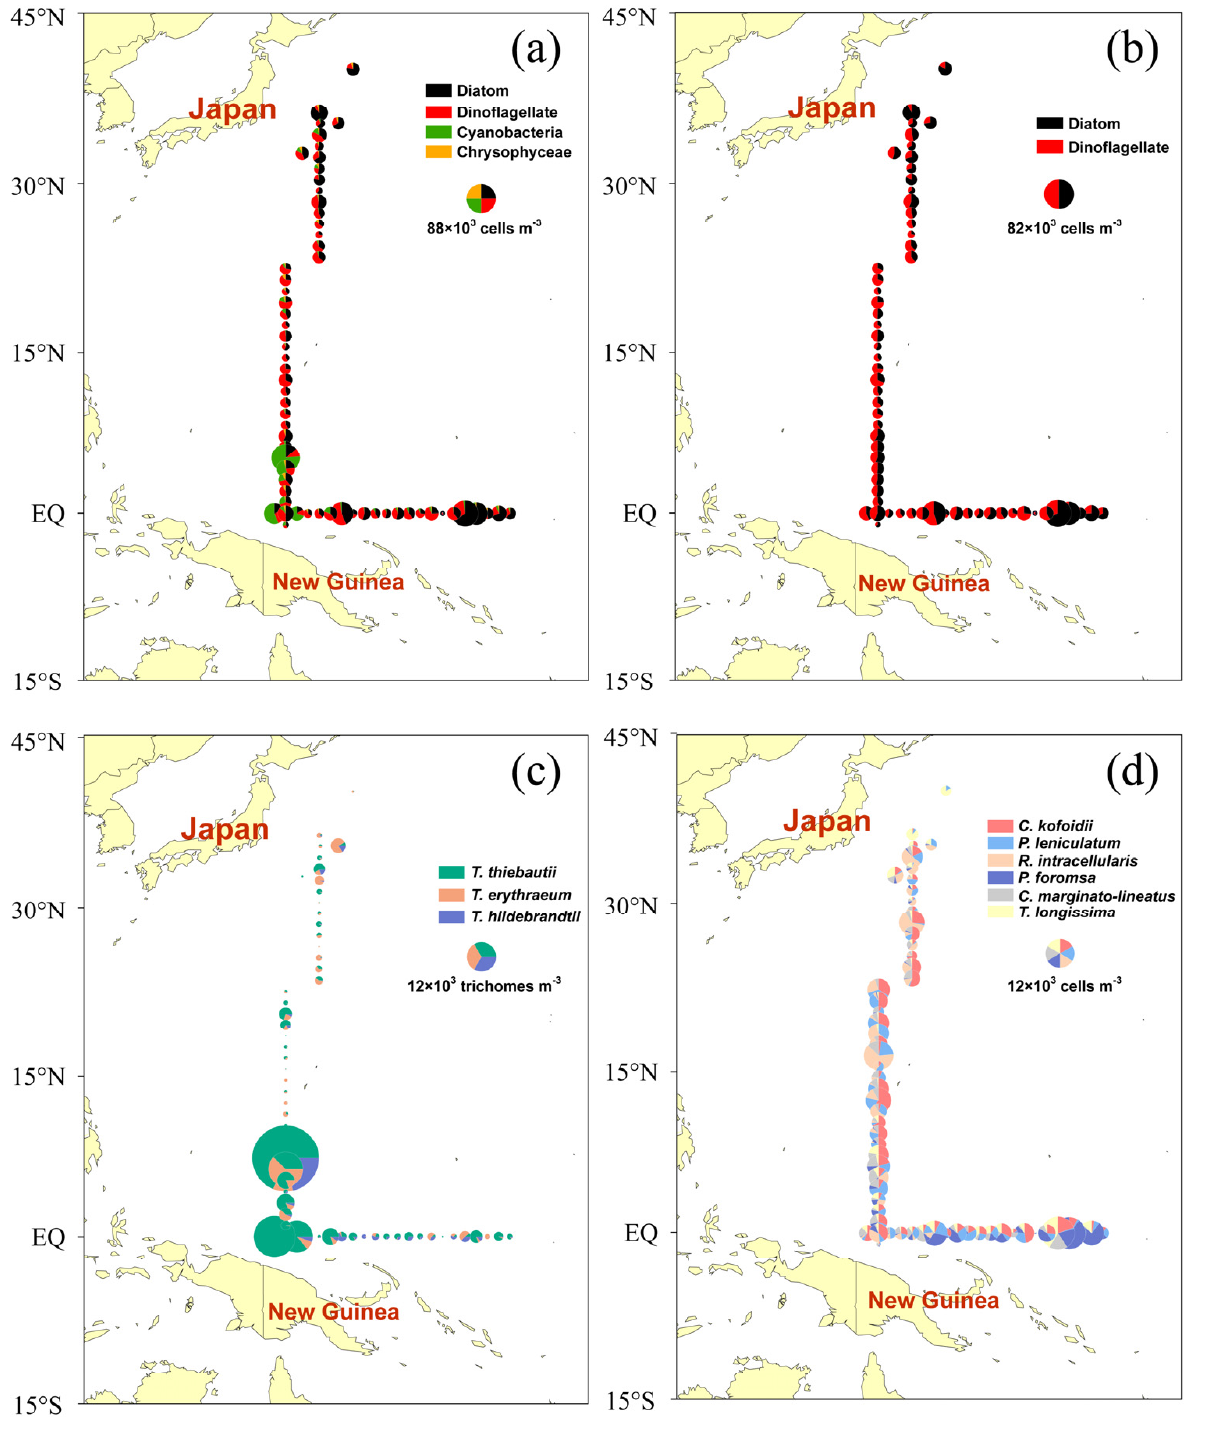
Figure 2. Horizontal distribution of phytoplankton abundance in the WPO. ( a ) Phytoplankton cell abundance of four-phyla (cells m − 3 ); ( b ) phytoplankton cell abundance of diatoms and dinoflagellates (cells m − 3 ); ( c ) phytoplankton cell abundance of Trichodesmium (trichomes m − 3 ); ( d ) dominant species abundance (cells m − 3 ). Table 2. Dominant phytoplankton species in the WPO.